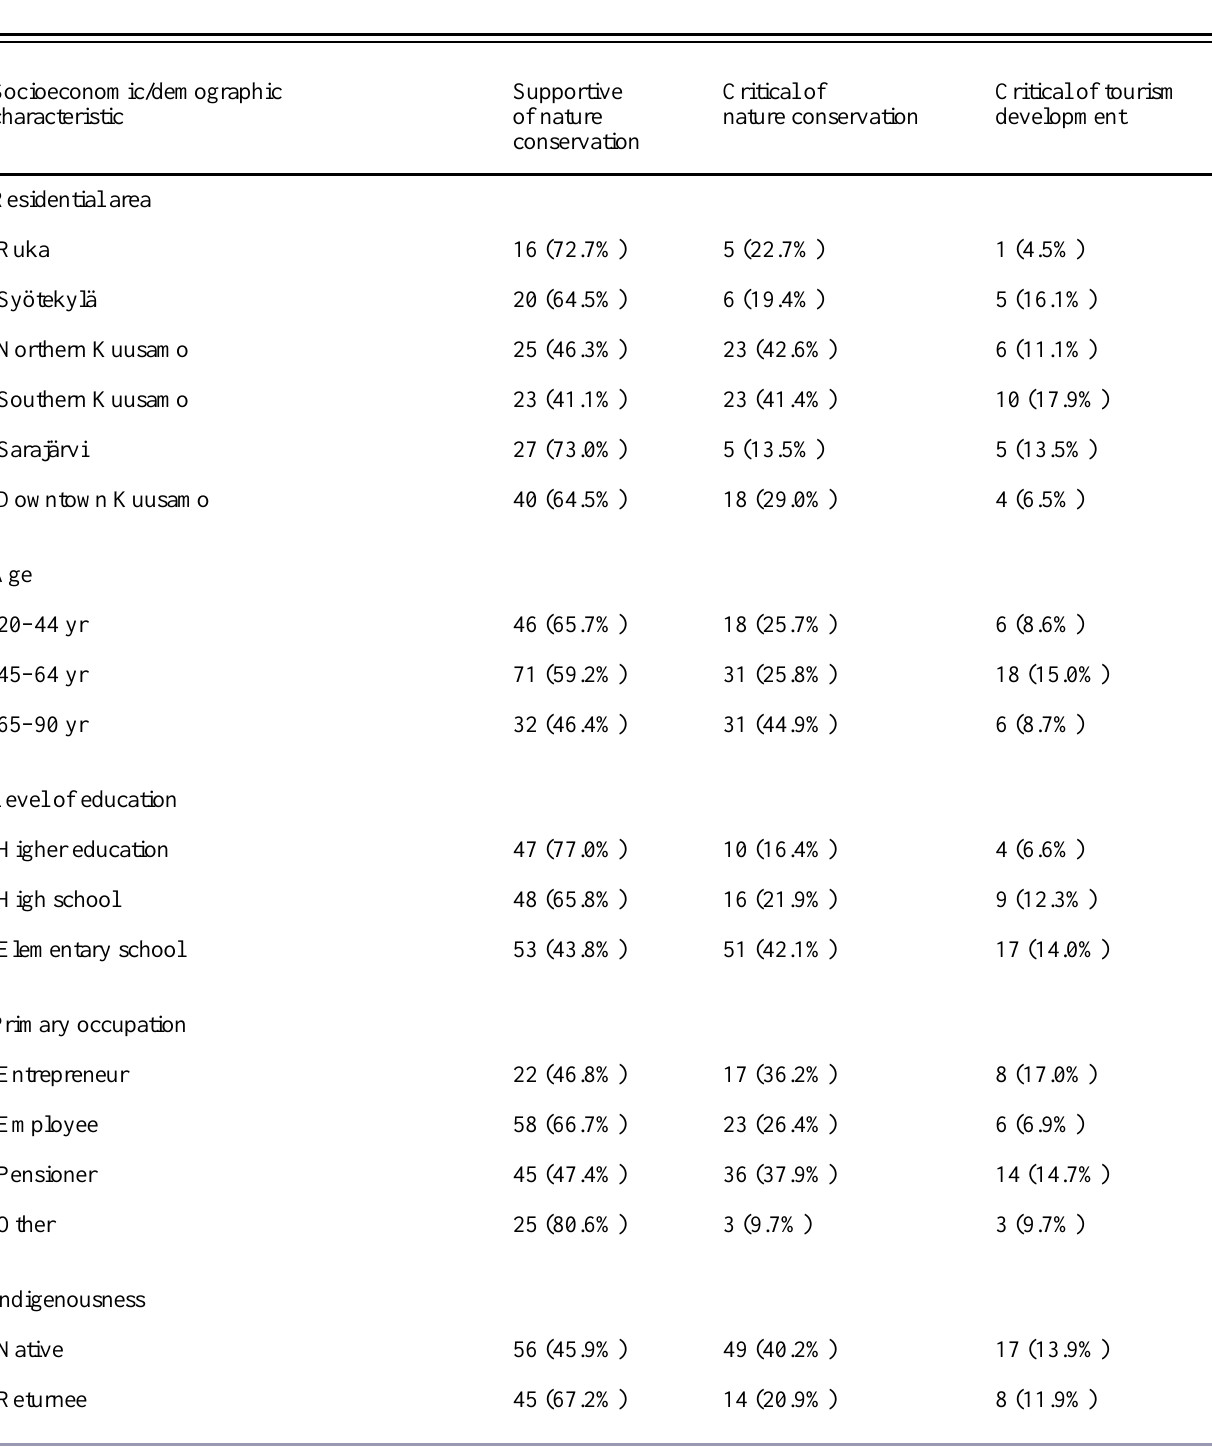
Table 5 . Frequencies of clusters (percentages in parentheses) in terms of the socioeconomic and demographic characteristics of the